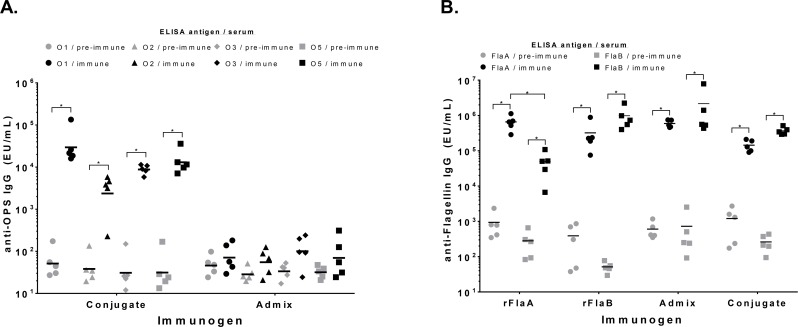
Immune response in rabbits to immunization with conjugates or admixed conjugate vaccine components.(A) Anti-polysaccharide IgG titers for O1 (circles), O2 (triangles), O3 (diamonds) or O5 (squares) OPS were assessed by ELISA for sera obtained from rabbits prior to immunization (pre-immune, grey symbols) and 14 days after the third dose (immune, black symbols) with the conjugate formulation or admixed OPS and flagellin components. (B) IgG antibody levels for rFlaA (circles) or rFlaB (squares) were assessed in sera obtained prior to vaccination (pre-immune, grey symbols) or 14 days after the third dose (immune, black symbols) of conjugate, admixed components or individual flagellin proteins. Each points represents an individual rabbit. Bars indicate the geometric mean titer. Statistical significance assessed by Mann-Whitney is indicated. *P < 0.05.